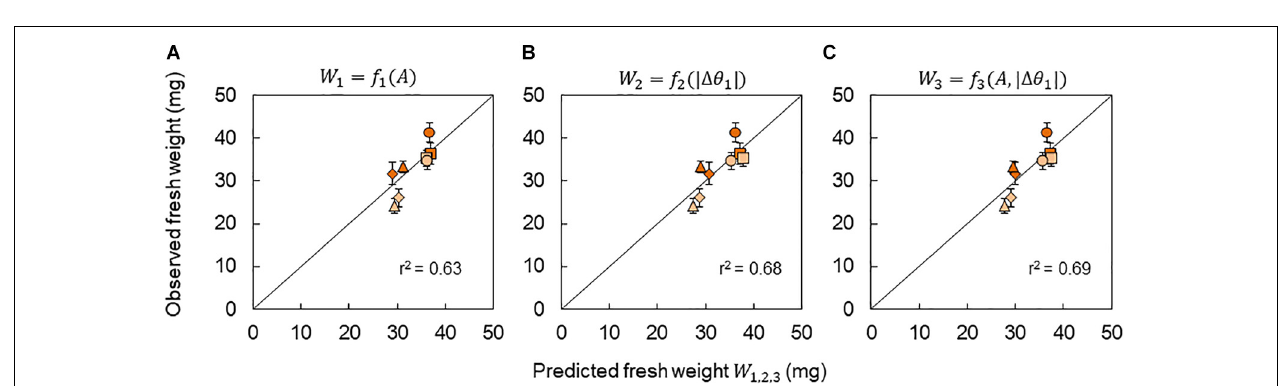
FIGURE 6 | Relationship between fresh weights and CCA1 rhythms in the conditions of L/D = 16/8 h and 4 h ± 10 ◦ C cycles. (A,B) Relationship between fresh weight and amplitude A (A) and difference of the locking phase | (cid:49) θ 1 | (B) in +10 ◦ C. (C,D) Relationship between fresh weight and A (C) and | (cid:49) θ 1 | (D) in the − 10 ◦ C. The blank symbols indicate data with negative values. Dotted arrows indicate the transform from negative to positive values. The colored symbols indicate data with positive values and the absolute value of the negatives in (B,D) . The solid lines indicate regression lines. (B,D) The regression lines are for the colored symbols.